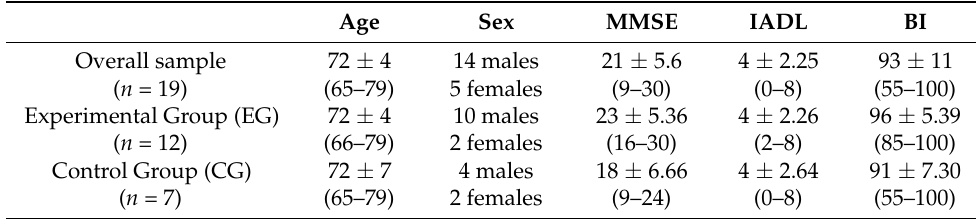
Table 2. Characteristics of the overall sample and